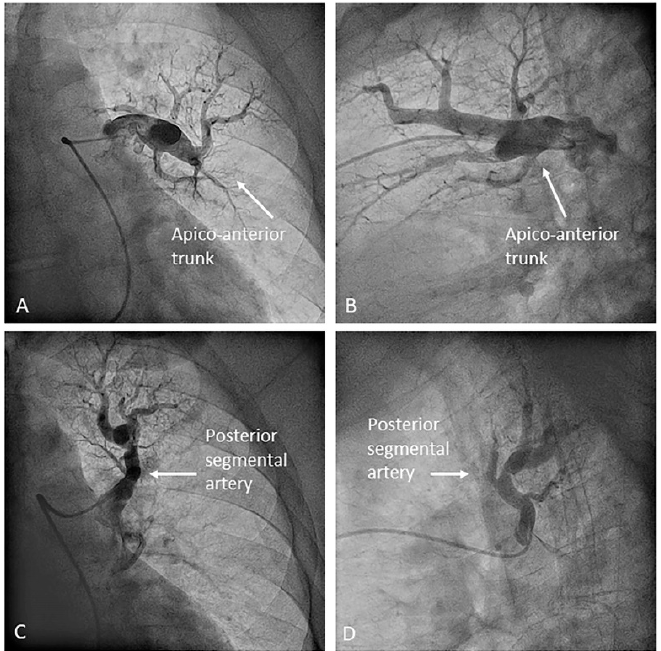
Figure 5. Left upper lobe arteries: ( A , B ) apico-anterior trunk (A1/3) and ( C , D ) posterior segmental branch (A2). ( A , C ) Anteroposterior view and ( B , D ) lateral view.